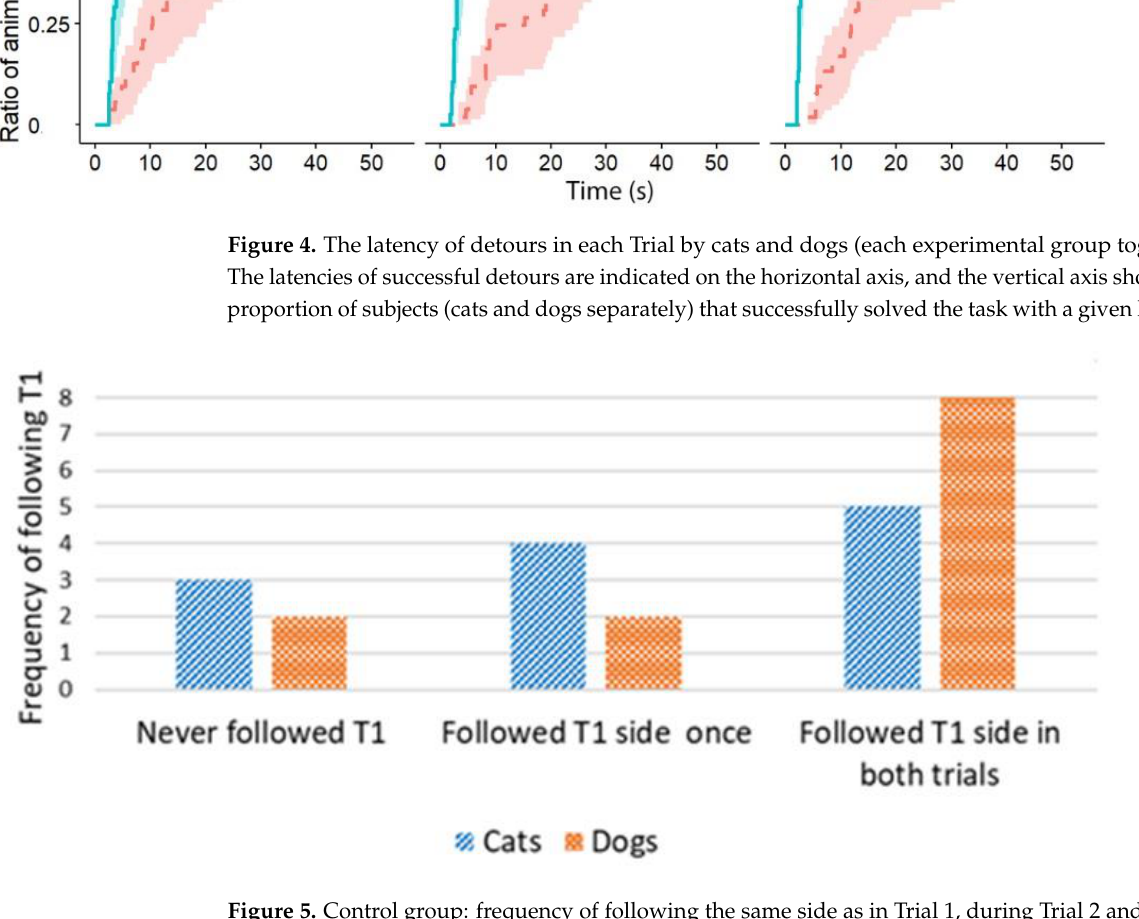
Figure 6. Detour-pointing group: frequency of following the same side as in Trial 1, during Trial 2 and Trial 3 (cats vs dogs). Out of 53 cats, only 5 animals looked back at the owner during problem-solving (3 from the control group, 1 from the straight-pointing group; 1 from the detour-pointing group). Out of the five cats, only two animals looked back more than once at the owner (2 and 4 times, respectively). Out of the 38 dog participants, 13 animals looked back at the owner, with 4 dogs looking back more than once (control group: 5, straight-pointing group: 5; detour-pointing group: 3). 4. Discussion We tested companion cats and dogs in similar indoor conditions, using identical pro- cedures in the classic detour task around a V-shaped transparent wire-mesh fence (e.g., [12,26,27]). To our knowledge, this is the first time that cats have been successfully tested in this detour paradigm in direct comparison with dogs. Our experiments showed that (1) dogs were faster to reach the food reward than cats; (2) the dogs, but not the cats, showed improvement in their detour latencies across the consecutive trials; (3) in the case of a successful first trial, the dogs continued to use the same side for detouring in the subse- quent trials , (4) while cats chose the side for detouring irrespective of their first successful trials; and (5) moving a laser pointer around the fence, thus ‘demonstrating’ a potential detour path, neither improved the speed of the detour, nor influenced the side choice of